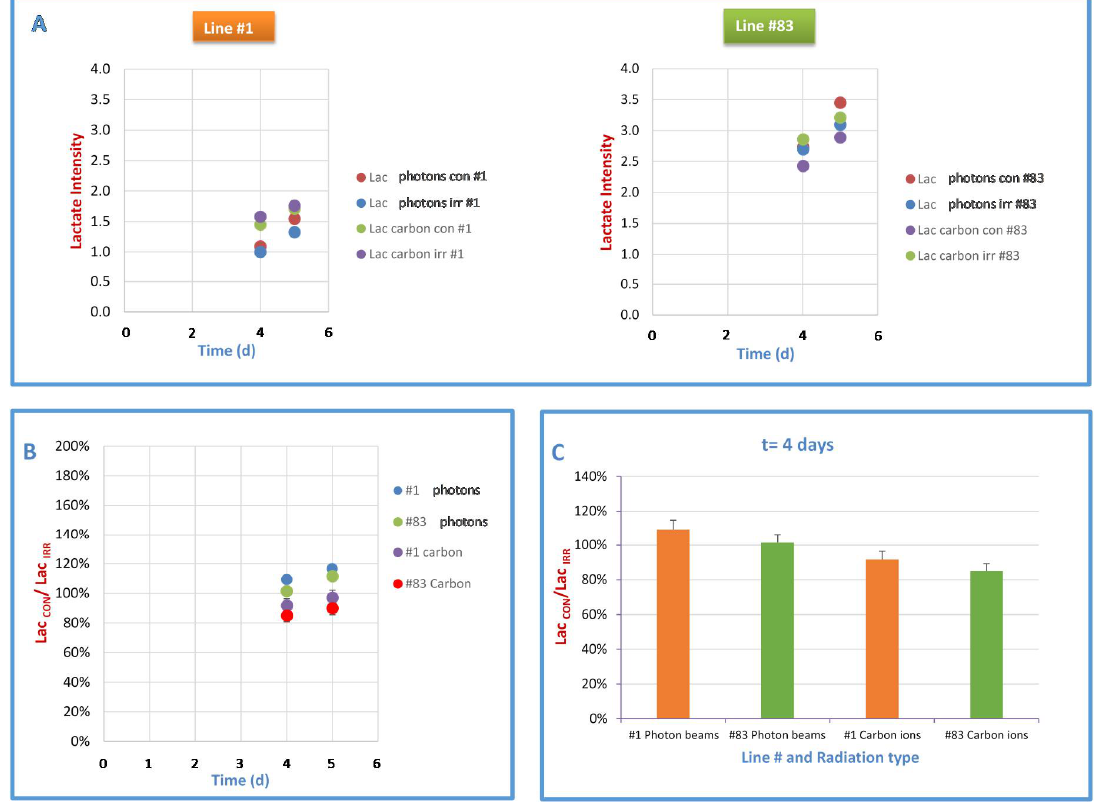
Figure 5. Lactate signal and cell number after photon and carbon ion irradiation. ( A ) lactate extrusion in culture medium, after photon and carbon ion irradiation at 20 Gy, as a function of time, for control and irradiated samples of line #1 and of line #83. Lactate doublet signal at 1.44 ppm was assigned and valuated in growth media spectra according to (Grande 2016) ( B ) Lac con / Lac irr ratio from lines #1 and #83 culture media spectra after irradiation with photons and carbon ions at 20 Gy as a function of